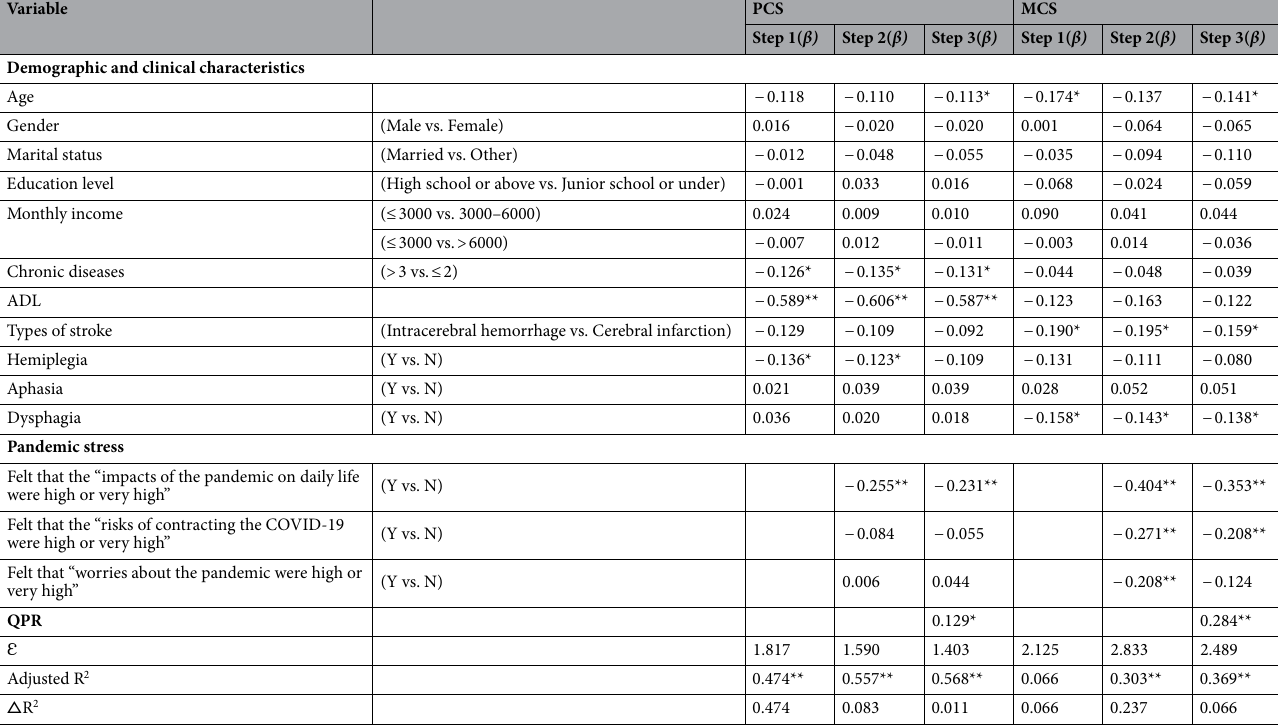
Table 4. Hierarchical multiple regression of PCS and MCS during the pandemic ( n = 172). Adjusted R 2 : A changed variation of R 2 that has been changed for the number of variables. The adjusted R 2 rises when the model improves with new blocks of variables; ΔR 2 :An index for measuring the proportion of the variability of the single variable or block that is explained by the models; β : the partial regression coefficient of the variables, which indicates the amount by which the dependent variable increases or decreases for each change of a specified independent variable by a unit; Ɛ : Constant; * p < 0.05, ** p <